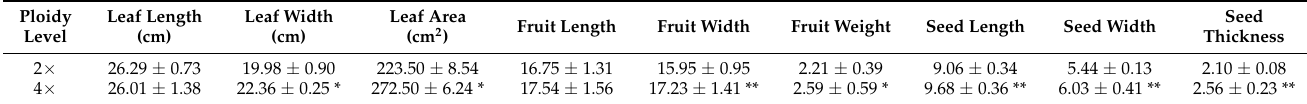
Figure 2. Morphological comparison between diploid and tetraploid watermelon: ( A ) plant leaf morphology; ( B ) fruit morphology; ( C ) seed morphology. Scale bar: 10, 5, and 2 cm, respectively. Table 1. Agronomic traits of diploid and tetraploid